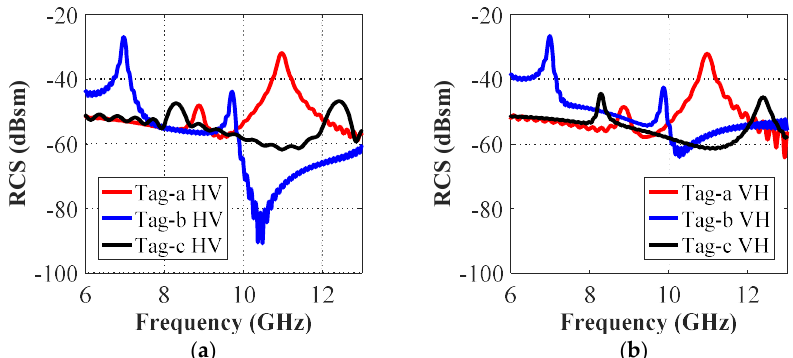
Figure 13. Cross-polar RCS simulation results of tag-a, -b, and -c: ( a ) Cross-polar HV RCS responses; ( b ) Cross-polar VH RCS responses.